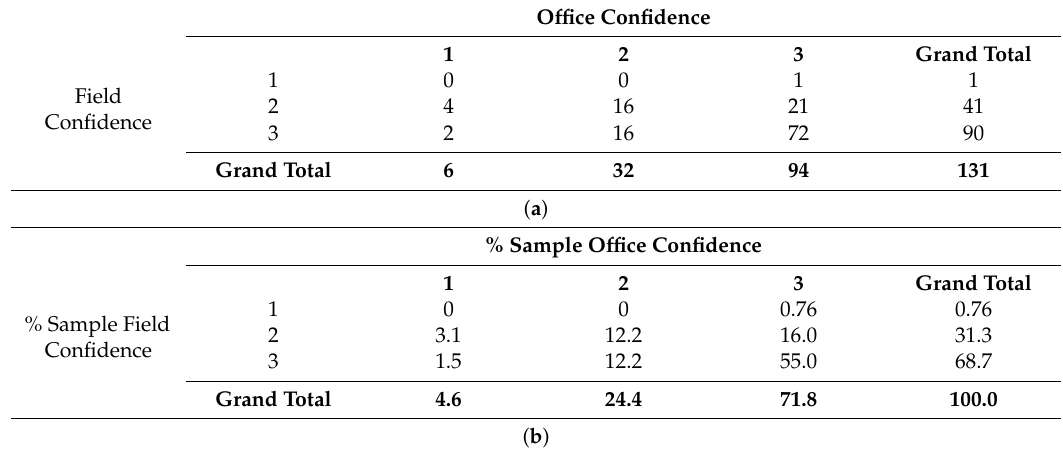
Table 5. Agreement matrix comparing agreement between office and field confidence levels for primary labels assigned in office and field for the random sample only: ( a ) raw numbers and ( b ) percent of